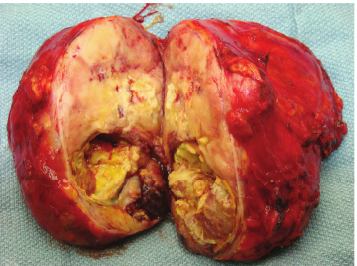
Figure 4: Right adrenal PEComa. It was a 14.5 × 12 × 7 cm fleshy tumor with necrosis and hemorrhage.